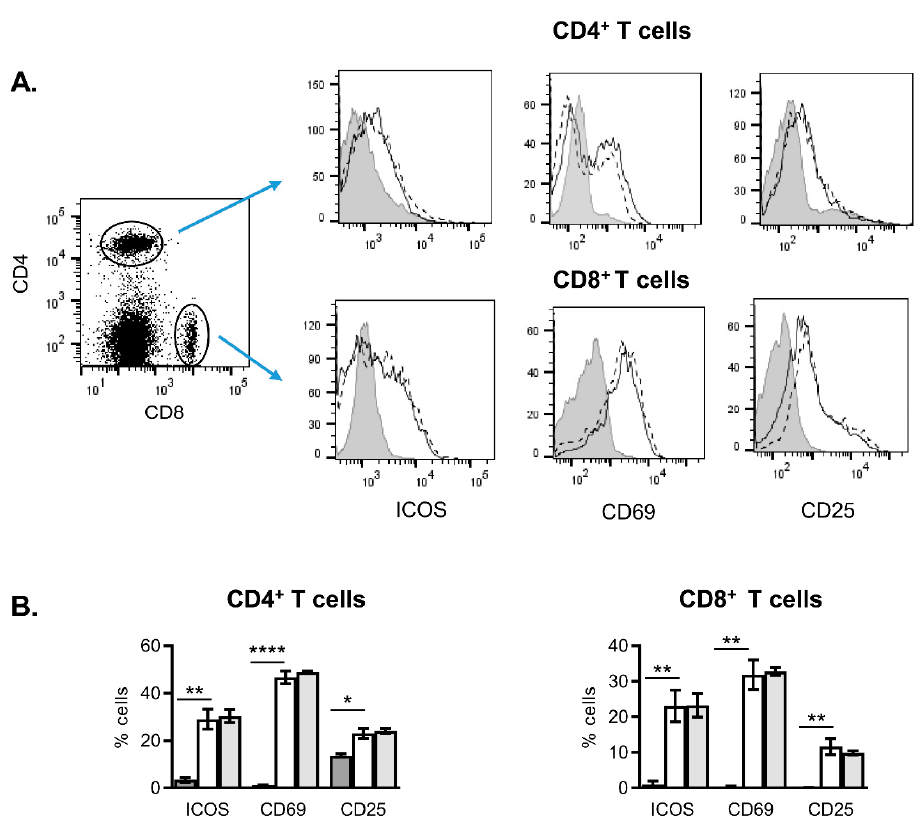
Figure 3. Effect of NanoMGBs on primary T cell activation. Analysis of activation markers (Inducible Costimulator, ICOS, CD25 and CD69) in spleen T-cells, activated for 24 h with anti-CD3 Ab. ( A ) Representative histograms showing the surface expression of ICOS, CD69 and CD25, in unstimulated (grey) spleen CD4 + or CD8 + T cells or after 24 h of anti-CD3 stimulus; in the absence (dashed) or presence (solid) of FITC-NanoMBGs. ( B ) Graphs showing percentage of cells positive for ICOS, CD69 or CD25 markers in CD4 + or CD8 + T cells. Basal expression (dark grey bars) or expression in activated cells in the absence (white bars) or presence (light grey bars) of FITC-NanoMBGs are shown. Mean ± SEM of one experiment out of three, each with three biological samples, is shown. Asterisks indicate significant di ff erence when activated vs. non-activated cells are compared. * p < 0.05; ** p < 0.01; **** p < 0.0001.